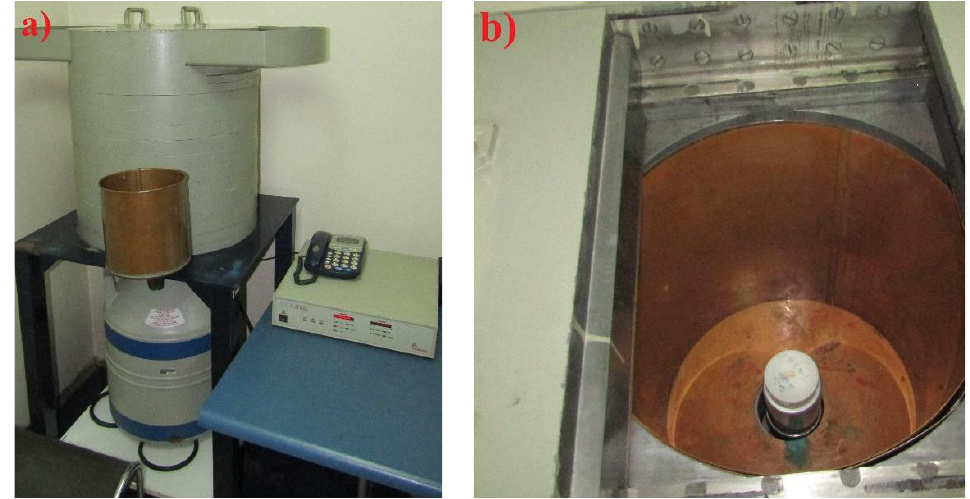
Figure 8. HPGe detector linked to a Canberra DSA-2000 Multichannel Analyzer coupled to the Genie 2000 software ( a ) and sample placed in the shield ( b ).